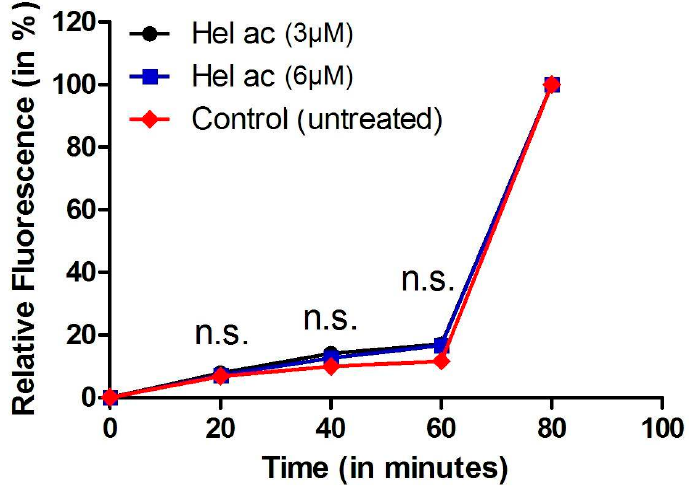
Figure 2. Permeability of L. (L.) infantum plasma membrane incubated with compound 1 assessed spectrofluorimetrically by the fluorescence of the SYTOX Green. Promastigotes were treated with 1 (3 and 6 μ M) for 60 min. At the end of this treatment, Triton X-100 was used for 100% permeabilization. Dimethyl sulfoxide (DMSO) was used as internal control and did not cause any alteration in membrane permeability (data not shown).